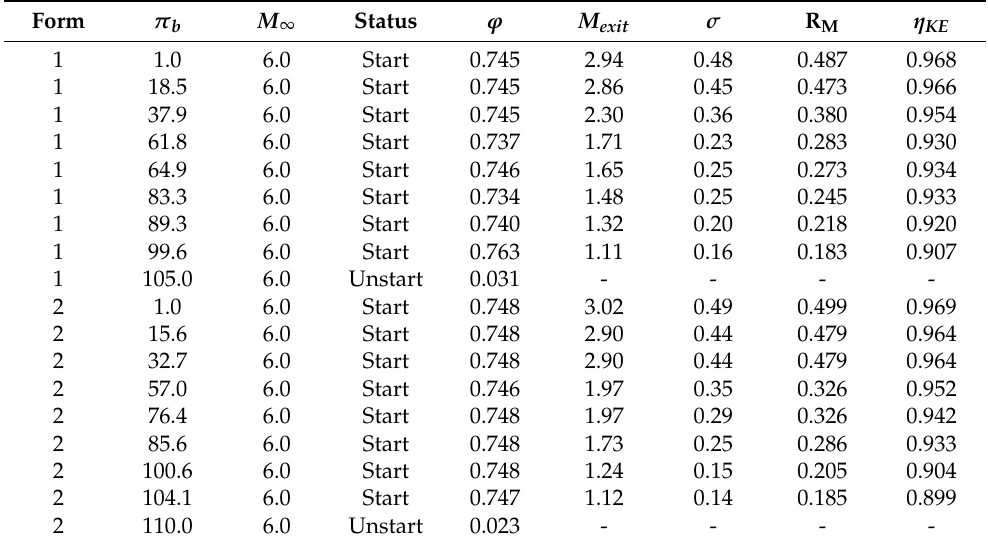
Table 3. Mass-averaged characteristics of bump inlets under various π b boundary conditions.